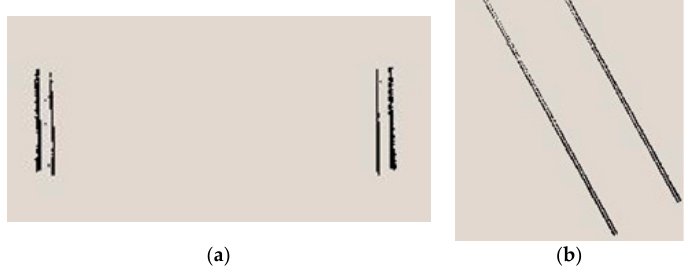
Figure 6. Fine extraction of rail point cloud. ( a ) Front View; ( b ) Top View.